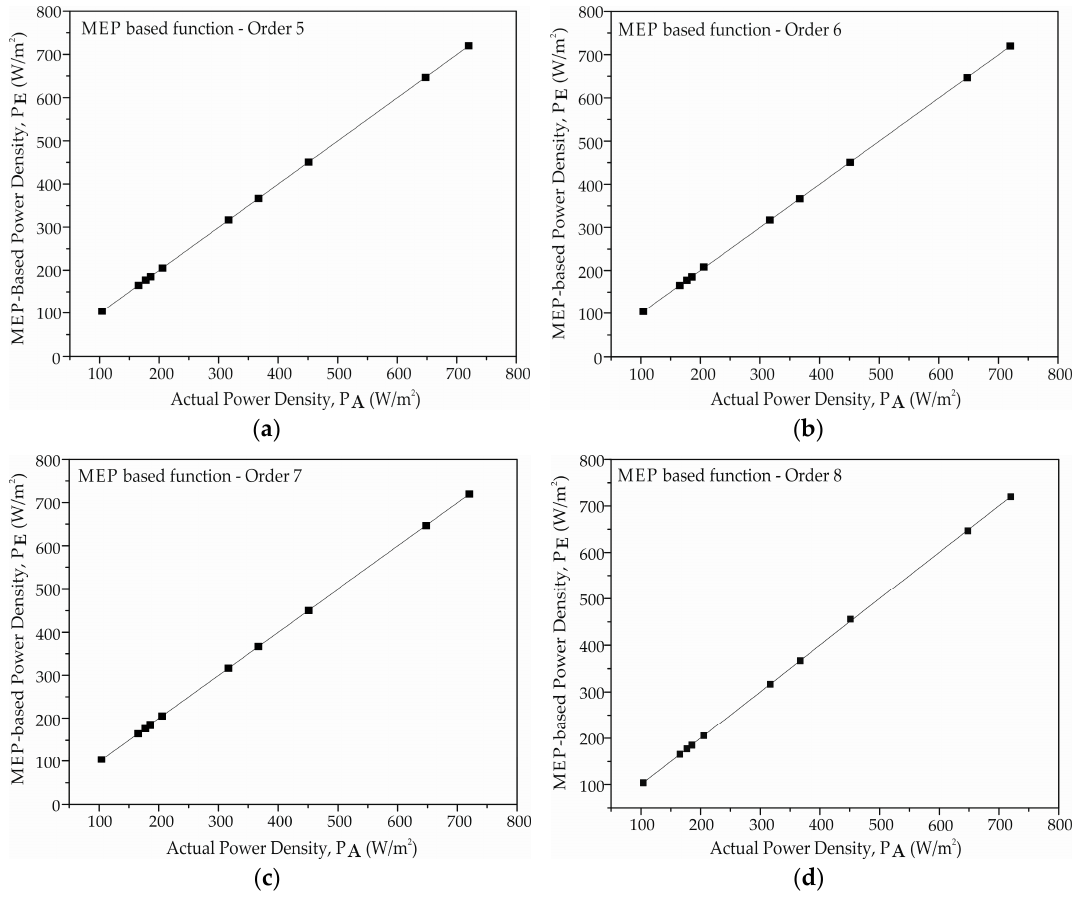
Figure 2. Scattered plot between calculated power density based on MEP ‐ based function and actual power density. Plots show power densities calculated using MEP ‐ based function for ( a ) order 5 ( b ) order 6 ( c ) order 7 and ( d ) order 8. Table 4. Monthly comparison of actual wind power densities ( P A ) with Weibull power densities ( P W ) (Table 2) and power densities based on MEP ‐ based function for orders 3–9 ( P E ).